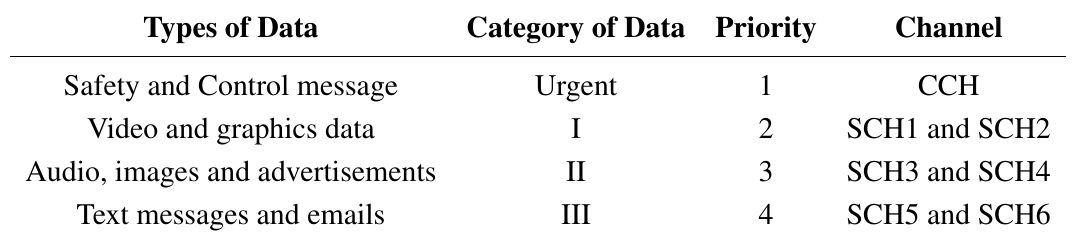
Table 1. Priority based data classification with channels. CCH, control channel; SCH, service